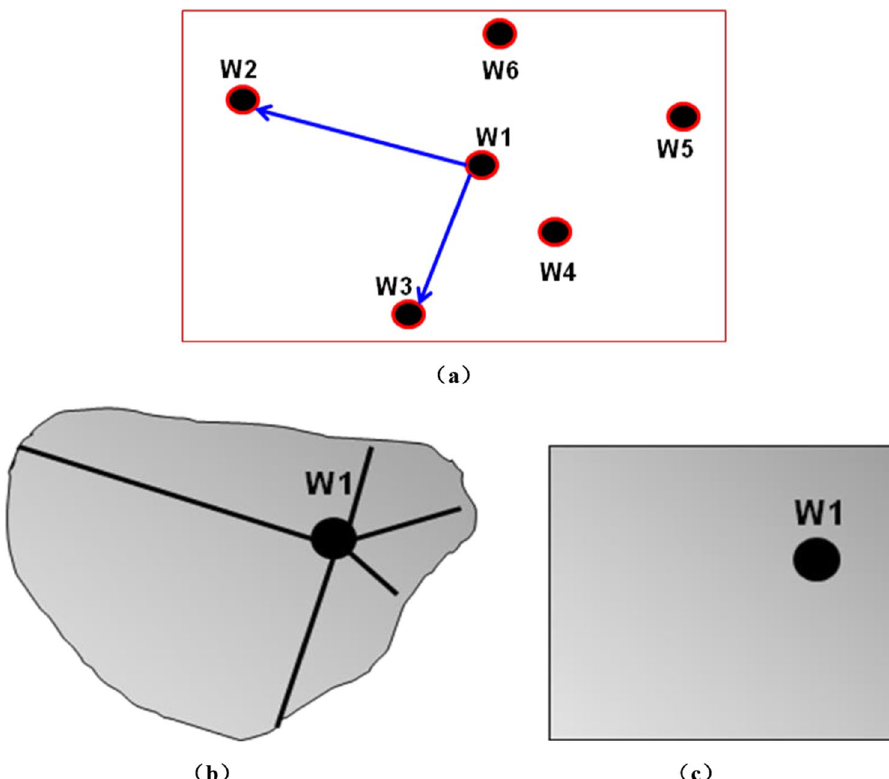
Fig. 4 Schematic diagram of well equivalent control area: a connectivity discriminate result; b actual control area; c equiva- lent control